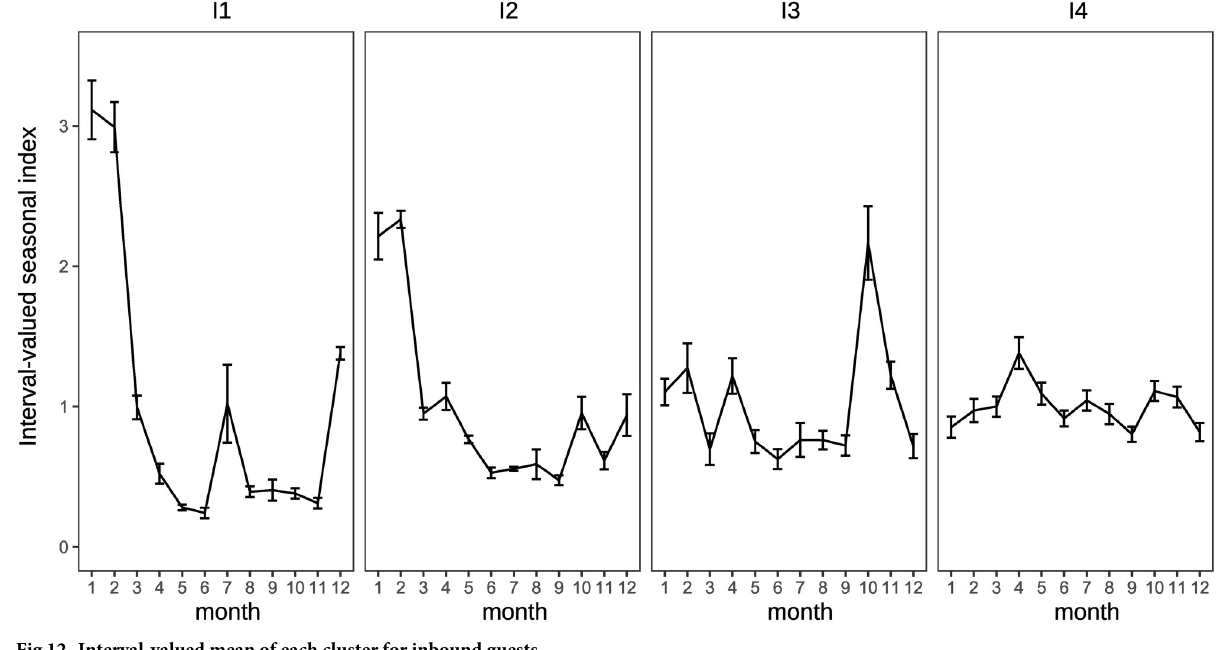
Fig 12. Interval-valued mean of each cluster for inbound